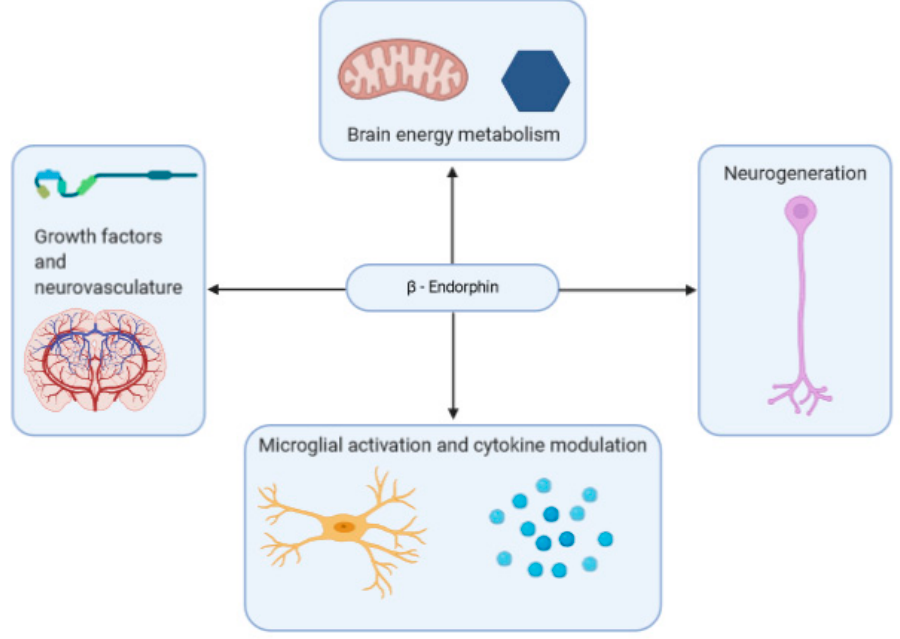
Figure 2. β -Endorphins exert a variety of effects on the brain that may impact brain health and neurodegenerative disorder.